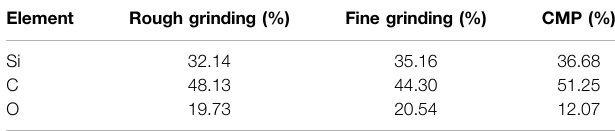
TABLE 1 | The atomic ratio of Si, C, and O elements at the surface of rough grinding, fi ne grinding, and CMP 4H-SiC wafer. Element